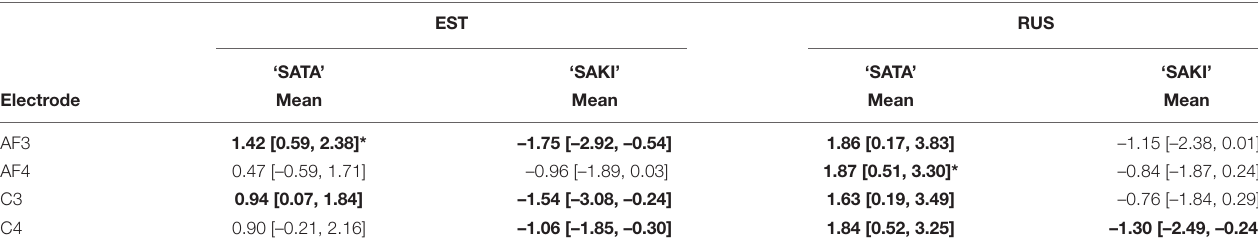
TABLE 9 | Results of bootstrap analysis for ‘Level ST-Falling DEV’ vs. ‘Falling ST-Level DEV’ conditions with 1000 resamplings for each Word set (‘SATA,’ ‘SAKI’), Language group (EST, RUS), and Electrode (AF3, AF4, C3, C4), models contained average activation of Duration comparisons × MMN. EST RUS ‘SATA’ ‘SAKI’ ‘SATA’